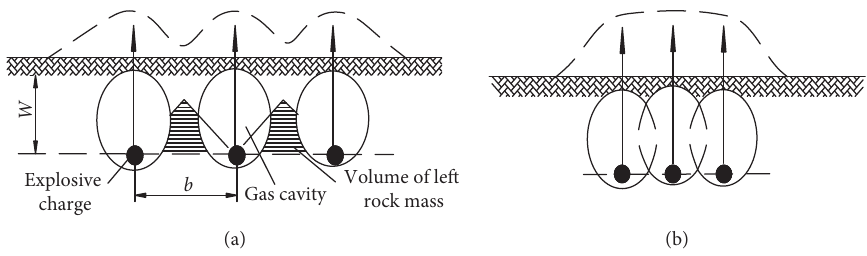
Figure 3: Blast-casting process of column charges forming in plane charge. (a) Widely spaced holes. (b) Closely spaced